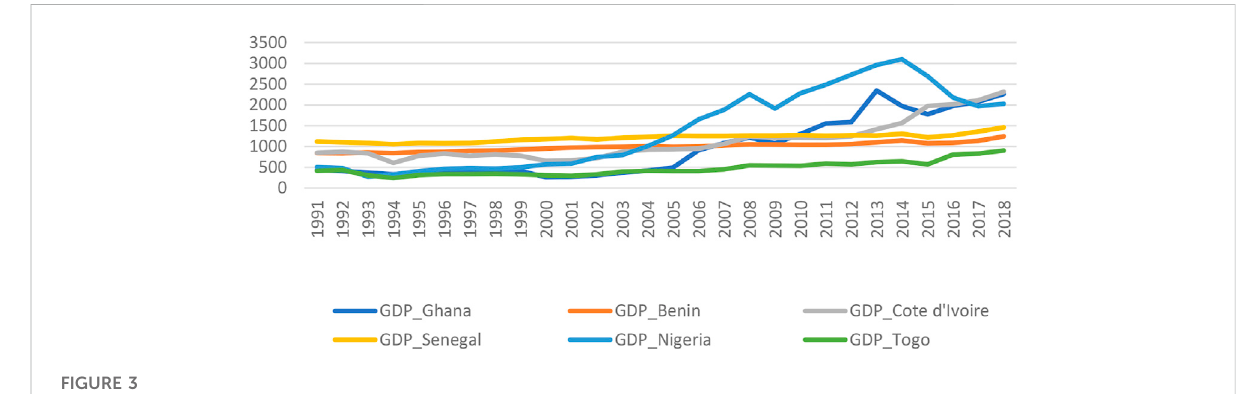
FIGURE 3 GDP levels of West African countries.